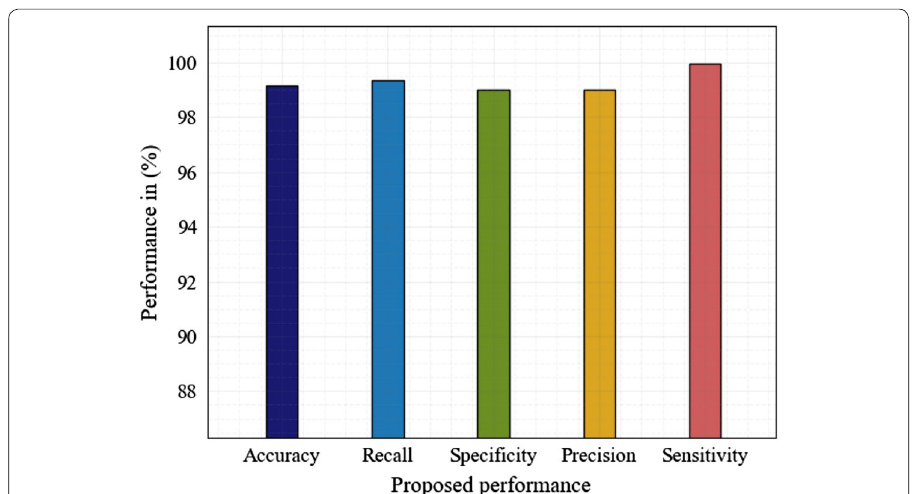
Fig. 12 Performance of proposed methods